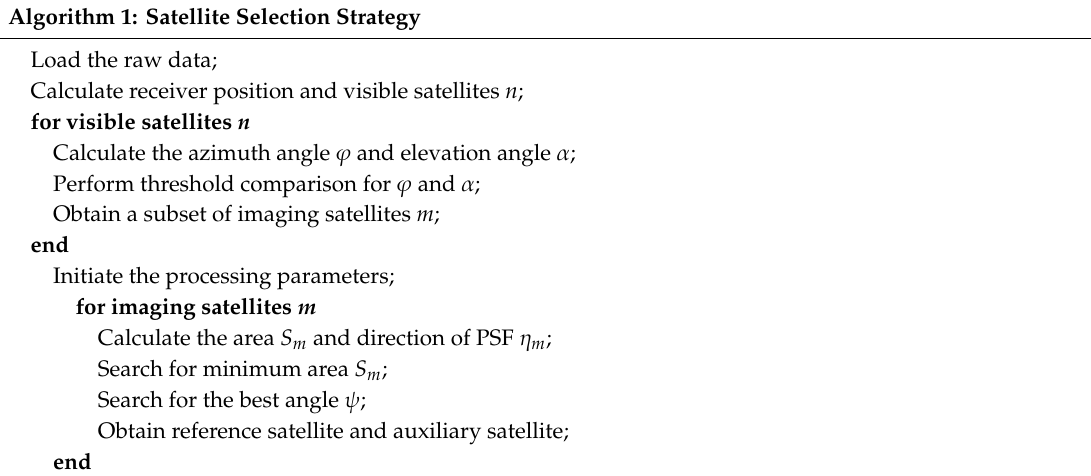
Algorithm 1: Satellite Selection